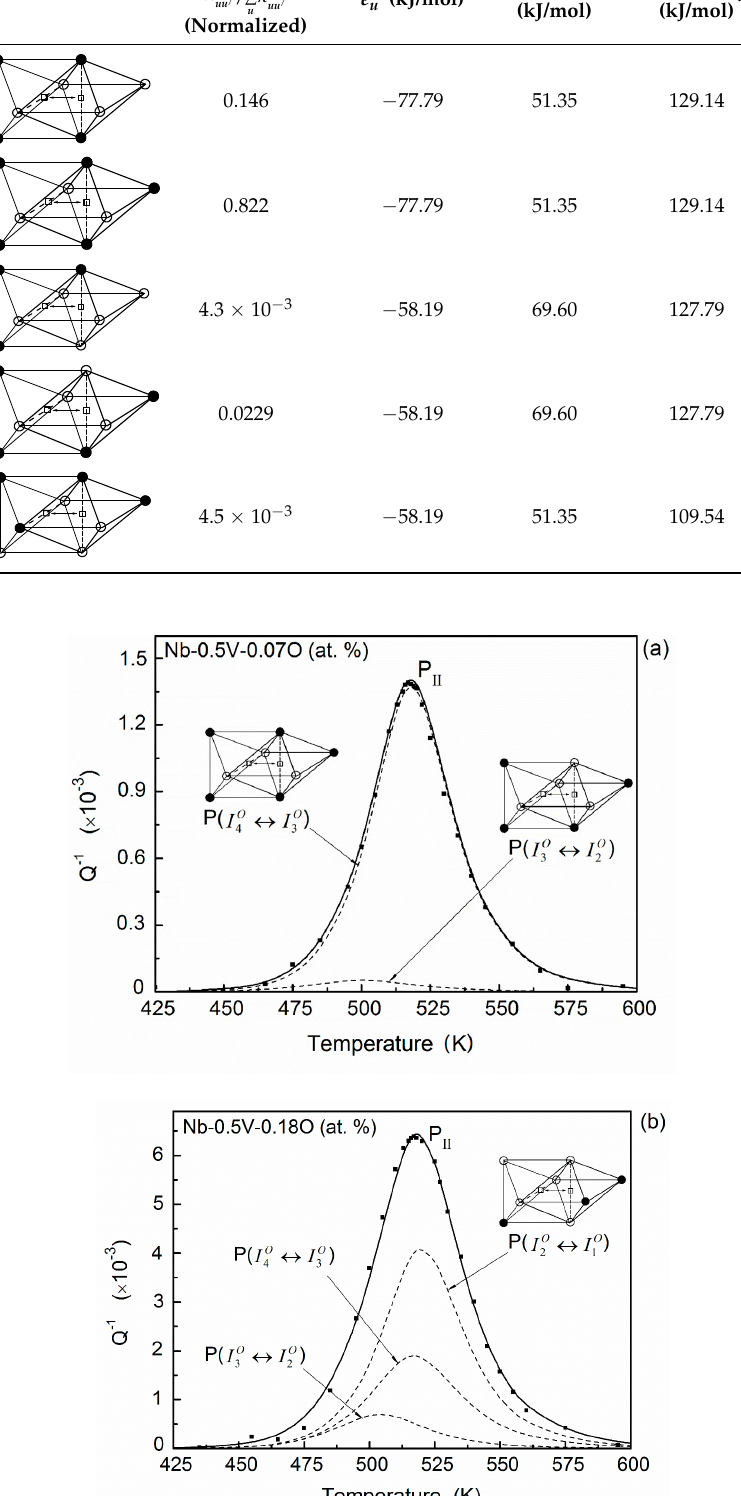
Figure 7. Temperature dependence of the relaxation peak and the fitting results for ( a ) Nb–0.5V– 0.07O, ( b ) Nb–0.5V–0.18O, and ( c ) Nb–0.5V–0.32O (at. %) alloys (points—experimental; dashed line— fitted elementary peaks; solid line—the sum of the elementary peak). ( ○ —Nb atoms, ● —V atoms).